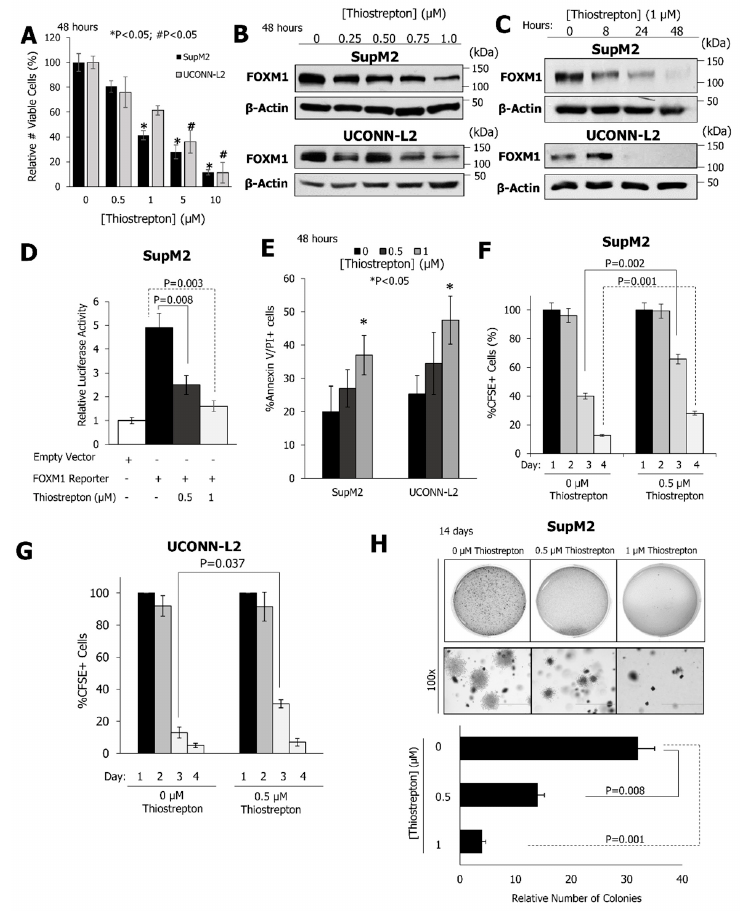
Figure 4. Pharmacological inhibition of FOXM1 inhibits cell growth and tumorigenicity. ( A ) The indicated cell lines were exposed for 48 h to thiostrepton, before the number of viable cells (normalized to DMSO) was assessed by an MTS assay. ( B ) Western blot of FOXM1 expression 48 h following exposure to thiostrepton in a dose-dependent manner. β -actin was used as a loading control. Anti-FOXM1 immunoblots were exposed for 1 min. ( C ) Western blot for expression levels of FOXM1 following exposure to 1 µM thiostrepton for the indicated times. Note that the exposure anti-FOXM1 immunoblots were exposed for 15–30 s. ( D ) Levels of luciferase activity in cells transiently transfected to express a FOXM1 promoter-luciferase reporter construct incubated in the presence or absence of thiostrepton for 48 h. ( E ) The fraction of cells to have undergone apoptosis, as defined by the co-expression of Annexin V and PI, in response to increasing doses of thiostrepton for 48 h. ( F , G ) Proportion of cells retaining CFSE following thiostrepton treatment for three or four days at the indicated dosages. ( H ) Colony formation in soft agar following incubation with increasing concentrations of thiostrepton for 48 h. The top panel shows overall colony growth in the plates with a 100x magnification while the lower panel shows colony counts. Data are representative of three biological replicates for SupM2 cells and two biological replicates for UCONN-L2